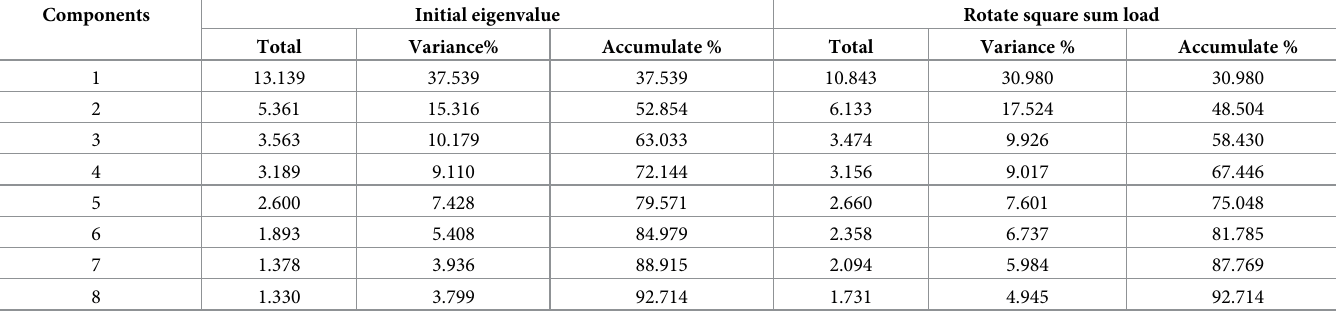
Table 2. Factor eigenvalue and cumulative variance contribution rate.